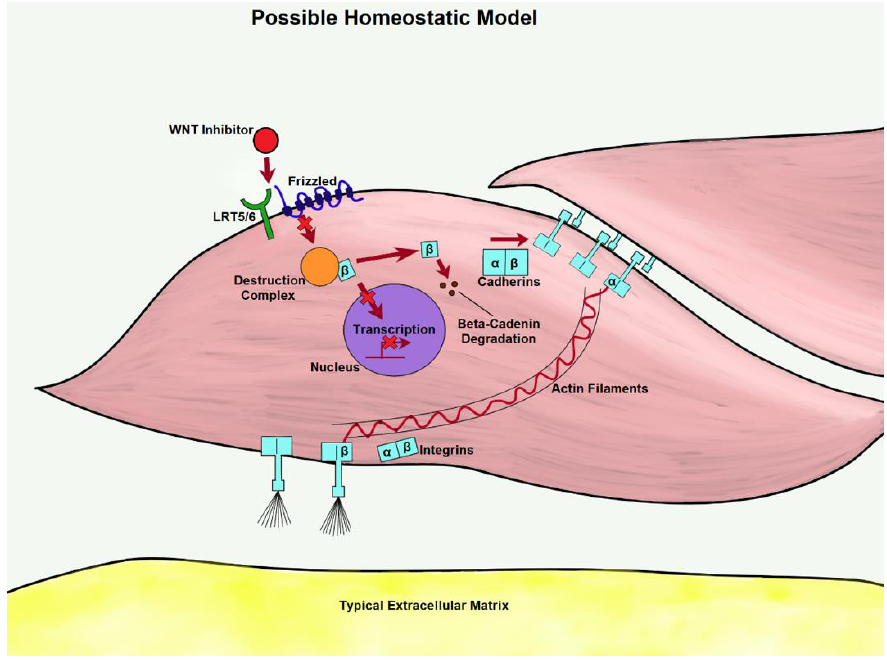
Figure 3. As WNT is inhibited in the homeostatic model, transcription is less likely to take place. β- catenin from disassociated adherins junctions (AJs) could be prevented from pooling through degradation, lowering the expression of matrix